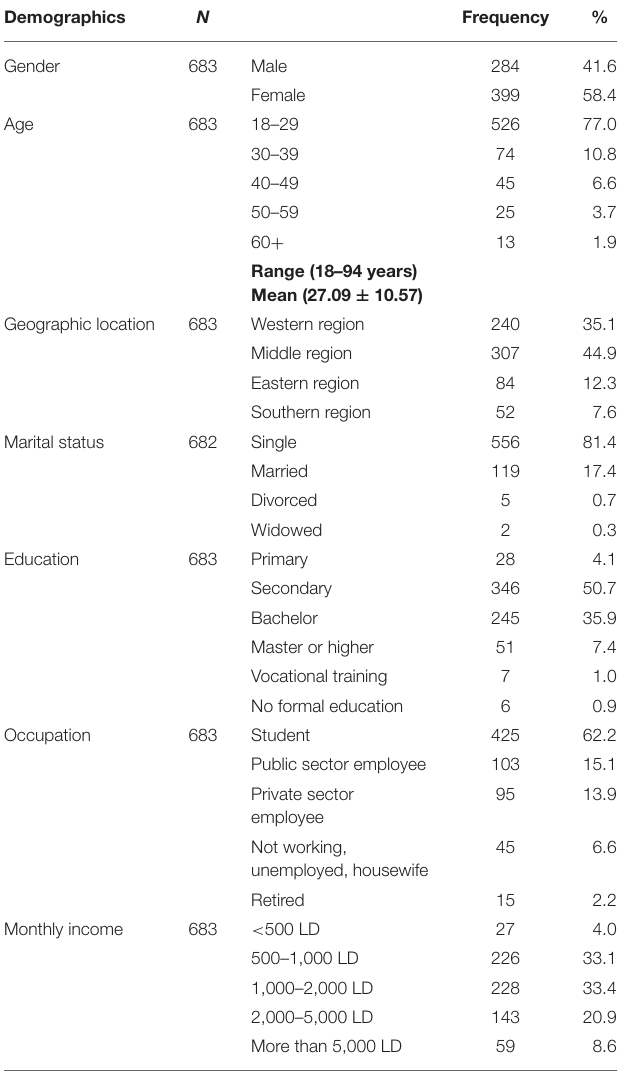
TABLE 1 | Demographic characteristics of study sample ( N =